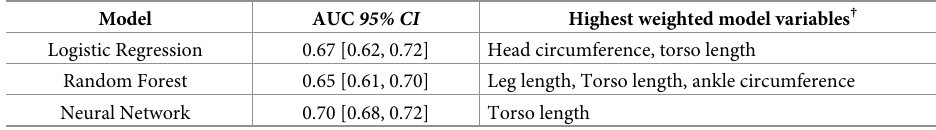
Table 2. Model AUC, 95% confidence interval and influential